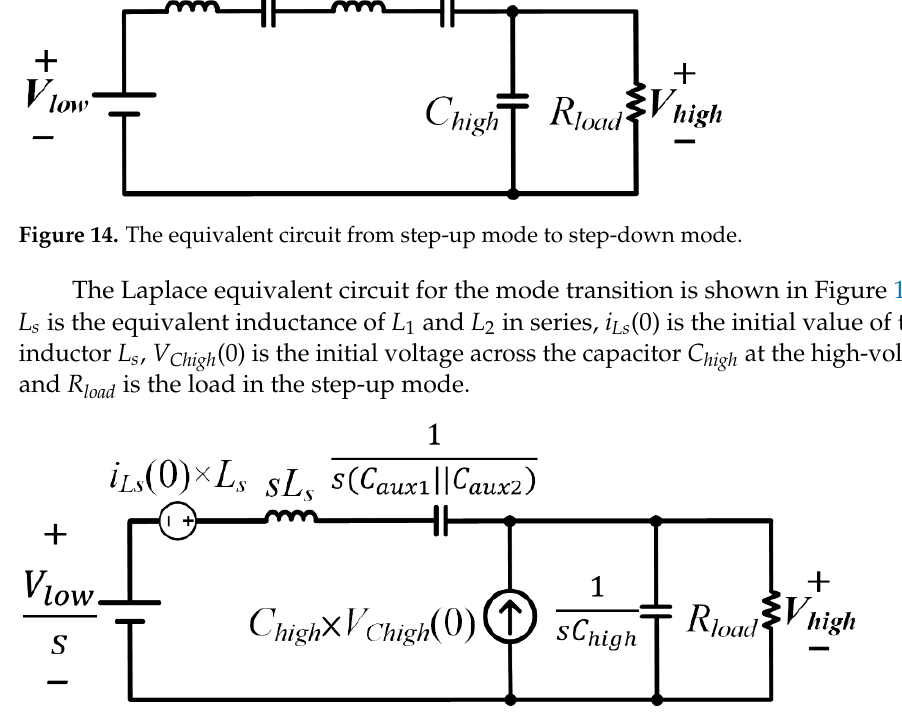
Figure 15. The Laplace equivalent circuit from step-up mode to step-down mode. The equivalent equation of the auxiliary capacitor voltage v Caux 1 is shown